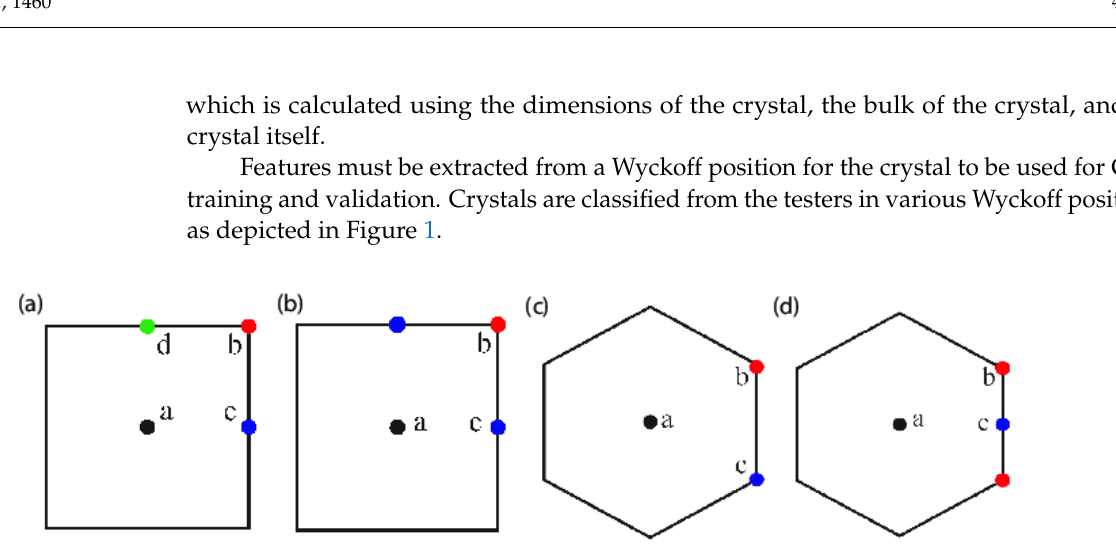
Figure 1. Wyckoff sites in unit cells of ( a ) C2; ( b ) C4; ( c ) C3; ( d ) C6 two-dimensional Bravais lattices (similar colors specify equivalent Wyckoff positions). Wyckoff positions are symbolized by a, b, c, and d.